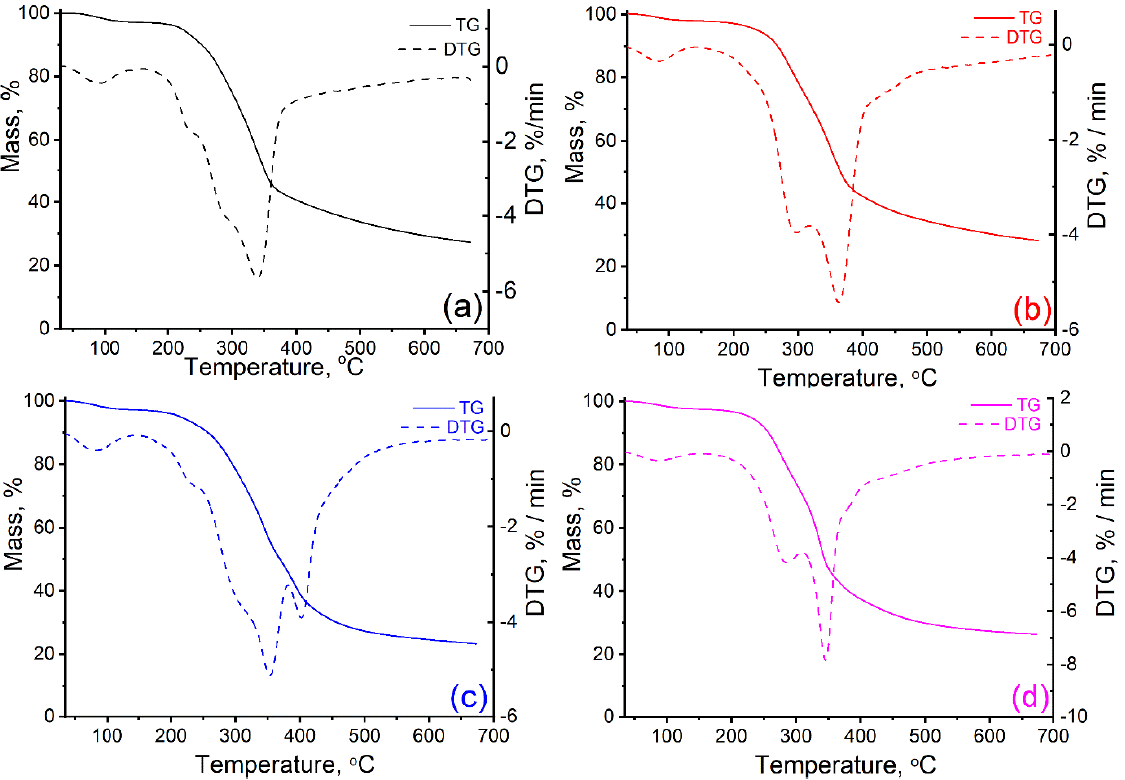
Figure 4. TG and DTG curves of walnut shells ( a ), and kernels of peach ( b ), apricot ( c ), and olive ( d ). Table 3. Thermal parameters obtained by thermal pyrolysis of walnut shells, peach, apricot, and olive kernels in an inert gas atmosphere (N 2